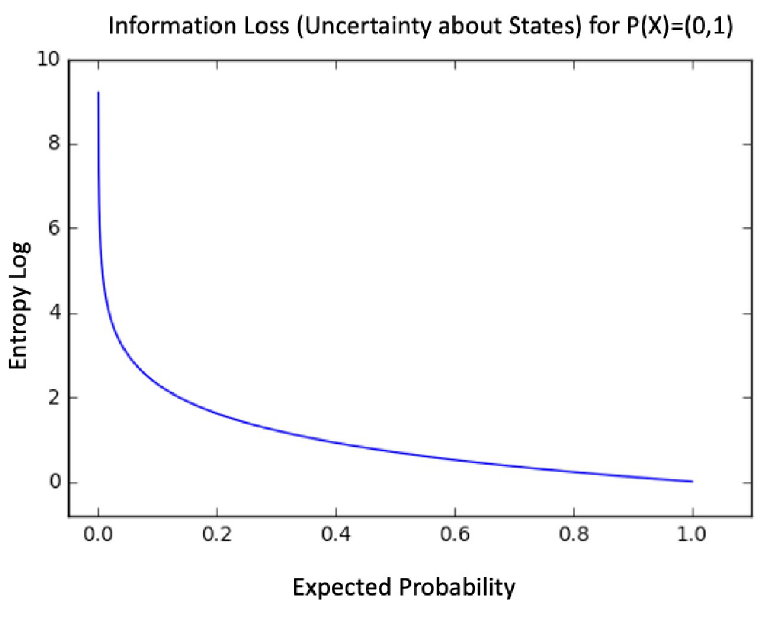
Fig 14. Entropy decrease process.